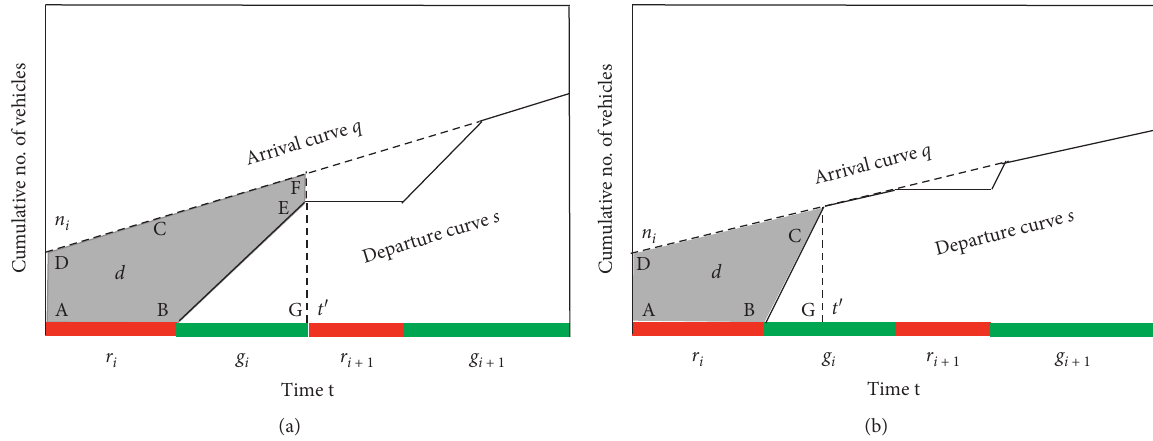
Figure 5: Delay in cycle i : (a) arrival traffic demand is higher than approach capacity. (b) Arrival traffic demand is lower than approach capacity. Table 3: Signal control intersections service level. Level of